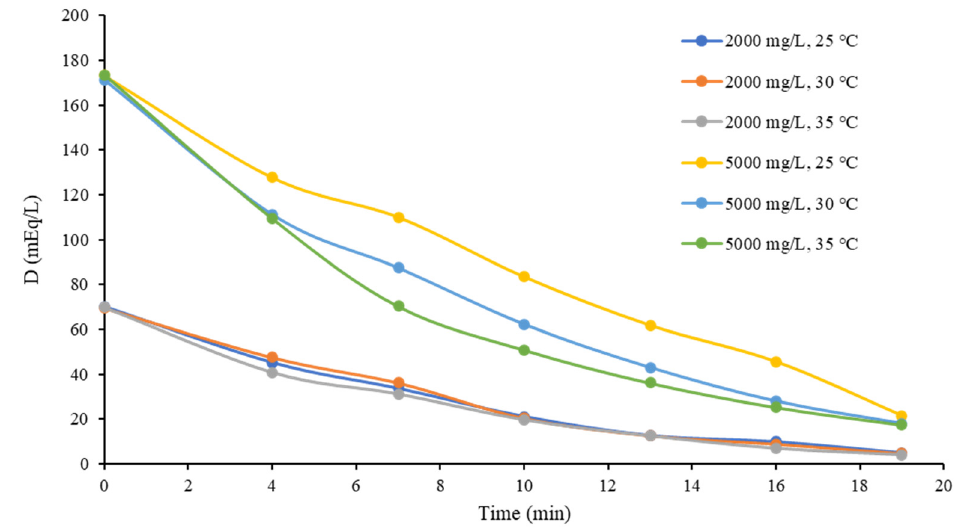
Figure 9. Diluate stream concentration over time at 20 V.